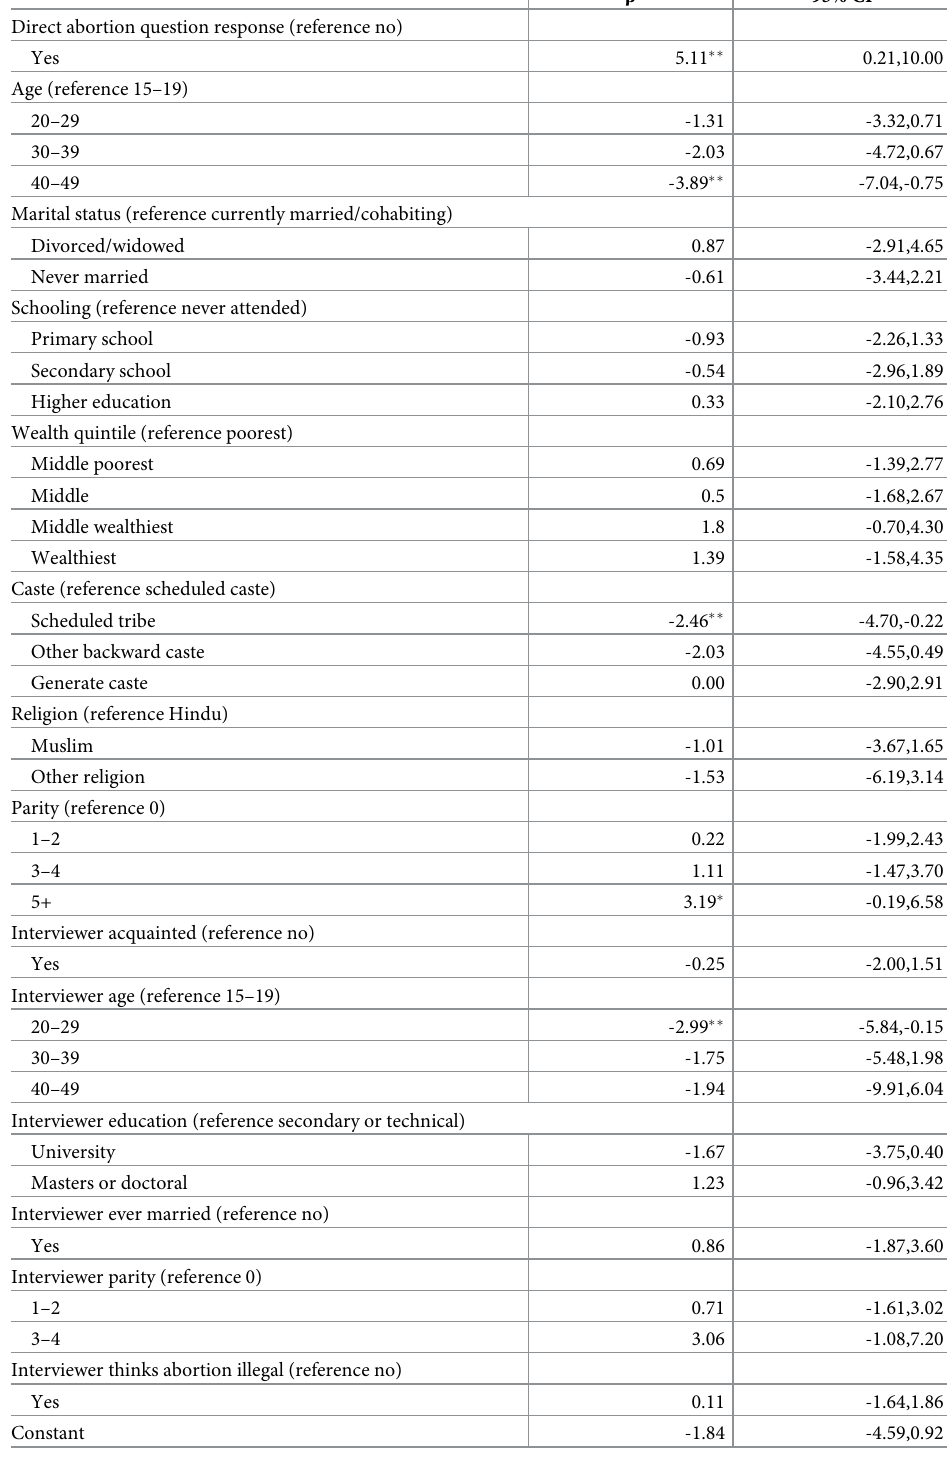
Table 4. Final random effects generalized least squares linear regression model of direct abortion reporting on within respondent difference in list experiment treatment and control list response latencies within interviewers 1